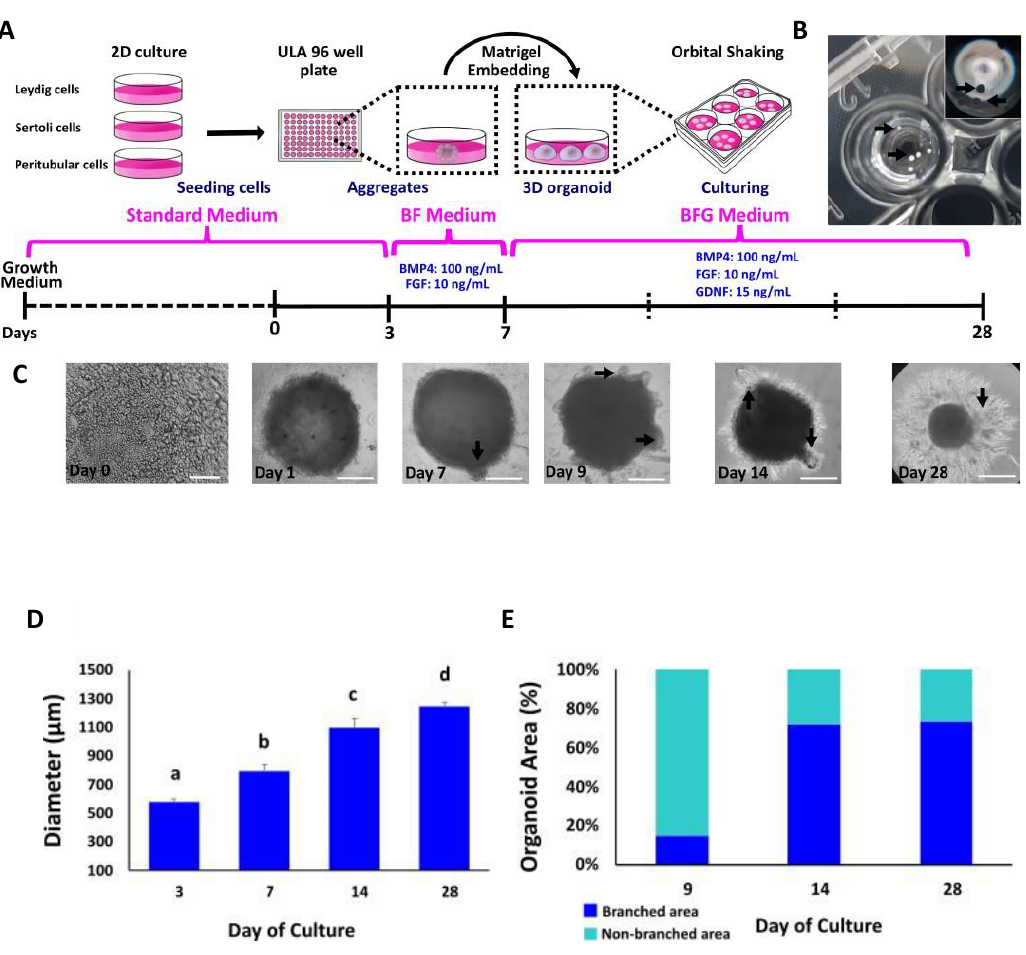
Figure 2. Generation and morphological evaluation of bovine TOs derived from primary bovine tes- ticular cells. ( A ) Schematic diagram depicting the main steps for bovine TO production. ( B ) Spherical TO after 3 days of culture in ULA plates. ( C ) Representative bright-field images of morphological changes and differences in cellular reorganization in TOs. Arrows indicate branch formation from days 7 to 28 after treatment with FGF2, BMP4 and GDNF. ( D ) Average diameter of TOs at different days of culture. ( E ) Percentage of branched and non-branched area on TOs at 9, 14 and 28 days of culture. Bright field at day 0 (Scale bar = 100 µ m). Data were expressed as the mean ± SEM ( n = 3). Days 1, 7, 9 and 28 (Scale bar = 500 µ m). Different superscripts (a, b, c and d) indicate significant ( p < 0.05) differences in diameter among days of